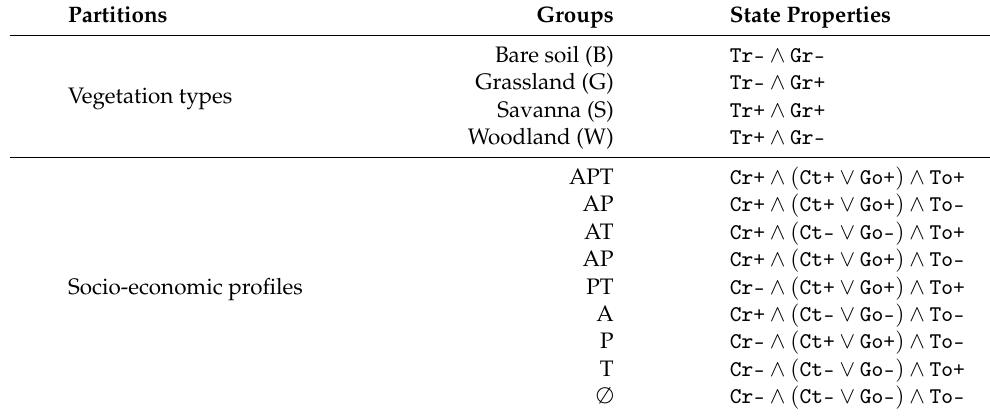
Table 3. Vegetation and socio-economic partitions. Each partition consists of several groups that are defined by state properties (i.e., the values of specific variables). Symbols ∧ and ∨ correspond to the logical AND and OR, respectively. Agriculture (A) = Cr+ , Pastoralism (P) = ( Ct+ ∨ Go+ ) , and Tourism (T) = To+ . Groups within a partition are mutually